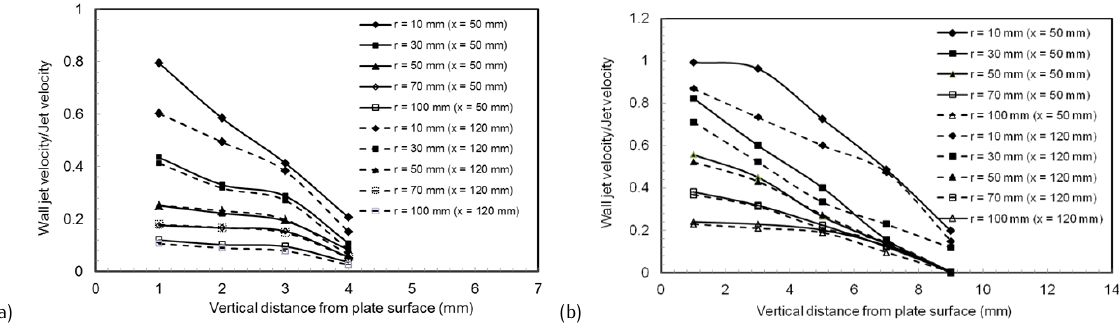
Figure 5. (a) Variation of wall jet velocity/jet velocity ratio with distances from plate surface for X = 50 & 120 mm at five different radial positions ( d = 10 mm ) ; (b) Variation of wall jet velocity/jet velocity ratio with distances from plate surface for X = 50 & 120 mm at five different radial positions (d = 20 mm).